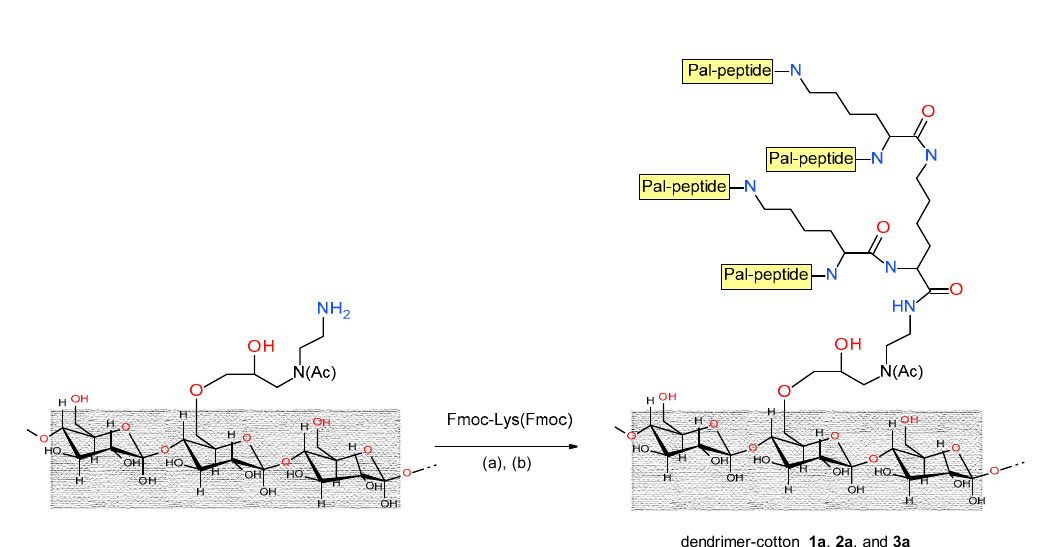
Scheme 1. Synthesis of peptide-cotton samples 1 , 2 , 3 and 3 ′ : ( a ) 60% HClO 4 in N,N- dimethylformamide (DMF); ( b ) triethylamine in DMF; ( c ) Ac 2 O, triethylamine in DMF; ( d ) 20% piperidine in DMF; ( e ) step-by-step solid-phase peptide synthesis (SPPS): Fmoc-AA-OH, HATU/HOAt, diisopropylethylamine (DIPEA) in DMF; then, piperidine in DMF; ( f ) last coupling: palmitic acid, HATU/HOAt, DIPEA in DMF.